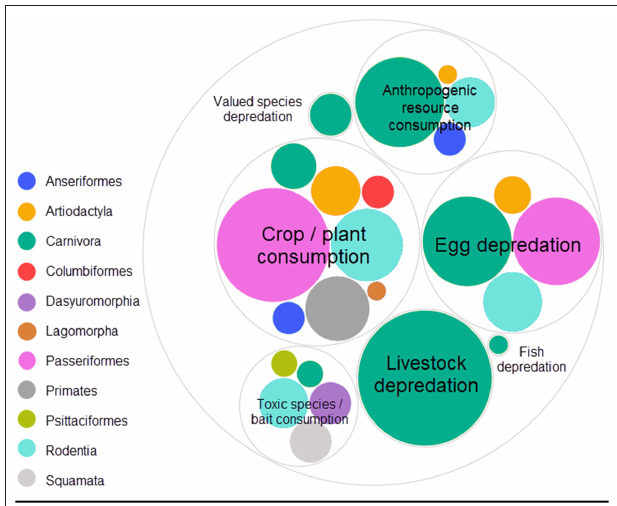
FIGURE 3 | Relative number of experiments per taxonomic order categorized by human-wildlife conflict category. The eleven orders belonged to three classes (birds, mammals and reptiles). One experiment is defined as a unique species, food, novelty and/or substance (application) combination. One publication can thus comprise several experiments. Valued species depredation’ comprises depredation of species that do not fit in the other depredation categories (e.g., game, pets and protected species), “Anthropogenic resource consumption” comprises resources that do not fit the other HWC categories (e.g., beehives, landfills, food hand-outs). Studies were retrieved via systematic search and ad hoc retrievals (see Methodology). Figure was created using RAW Graphs 2.0 beta (Mauri et al., 2017) and further edited in Snagit Editor Version 2020.1.3 (TechSmith Corp., Okemos, USA).